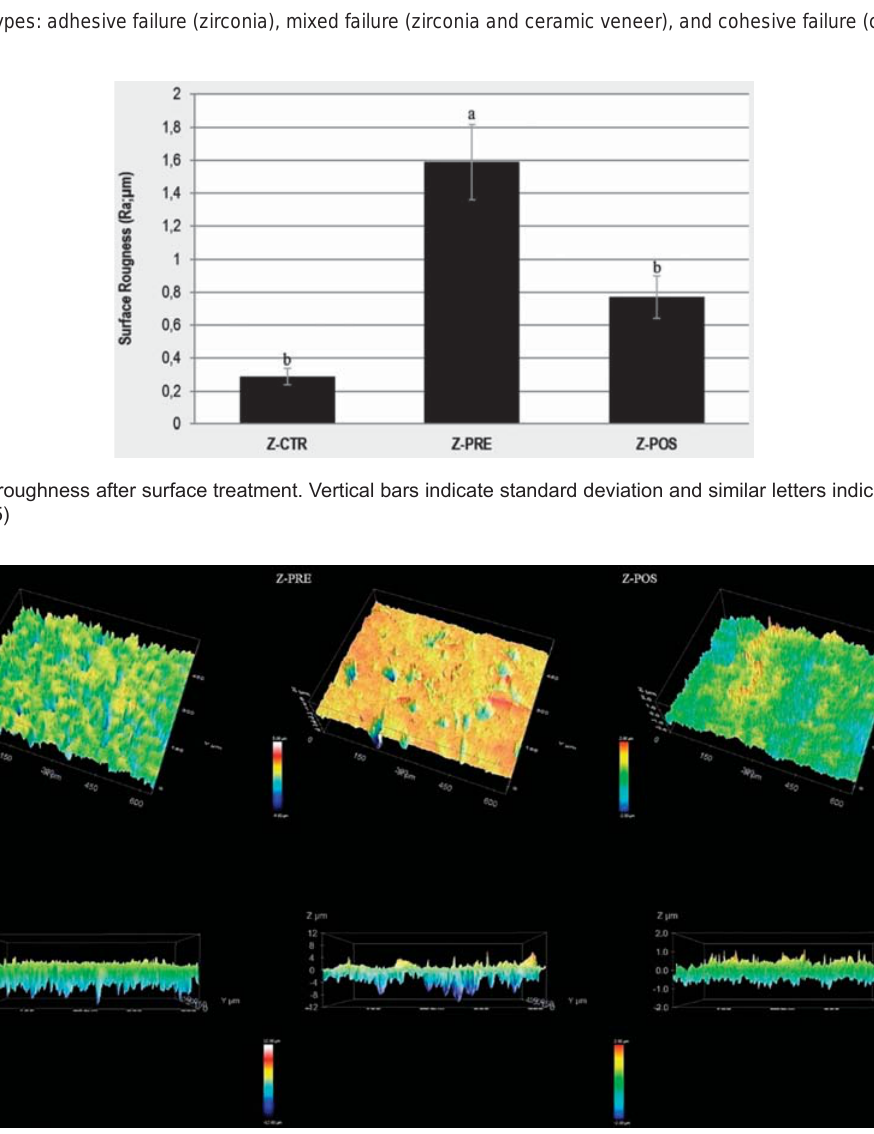
Figure 8- 3D representative images of view of surface. Z-CTR – prominent deep valleys (blue sites) and crests distributed homogeneously (cid:82)(cid:89)(cid:72)(cid:85)(cid:3)(cid:87)(cid:75)(cid:72)(cid:3)(cid:86)(cid:88)(cid:85)(cid:73)(cid:68)(cid:70)(cid:72)(cid:17)(cid:3)(cid:44)(cid:81)(cid:3)(cid:87)(cid:75)(cid:72)(cid:3)(cid:71)(cid:72)(cid:72)(cid:83)(cid:3)(cid:89)(cid:76)(cid:72)(cid:90)(cid:3)(cid:82)(cid:73)(cid:3)(cid:87)(cid:75)(cid:72)(cid:3)(cid:86)(cid:88)(cid:85)(cid:73)(cid:68)(cid:70)(cid:72)(cid:15)(cid:3)(cid:87)(cid:75)(cid:72)(cid:3)(cid:89)(cid:68)(cid:79)(cid:88)(cid:72)(cid:86)(cid:3)(cid:68)(cid:85)(cid:72)(cid:3)(cid:88)(cid:81)(cid:71)(cid:72)(cid:85)(cid:3)(cid:16)(cid:24)(cid:3)(cid:541)(cid:80)(cid:15)(cid:3)(cid:68)(cid:81)(cid:71)(cid:3)(cid:87)(cid:75)(cid:72)(cid:85)(cid:72)(cid:3)(cid:68)(cid:85)(cid:72)(cid:3)(cid:86)(cid:79)(cid:76)(cid:74)(cid:75)(cid:87)(cid:3)(cid:70)(cid:85)(cid:72)(cid:86)(cid:87)(cid:86)(cid:3)(cid:68)(cid:79)(cid:82)(cid:81)(cid:74)(cid:3)(cid:87)(cid:75)(cid:72)(cid:3)(cid:86)(cid:88)(cid:85)(cid:73)(cid:68)(cid:70)(cid:72)(cid:17)(cid:3)(cid:61)(cid:16)(cid:51)(cid:50)(cid:54)(cid:3)(cid:177)(cid:3)(cid:71)(cid:72)(cid:72)(cid:83)(cid:3) valleys (blue sites) and crests (red sites) concentrated in certain areas of the surface, with more heterogeneous distribution, ranging from